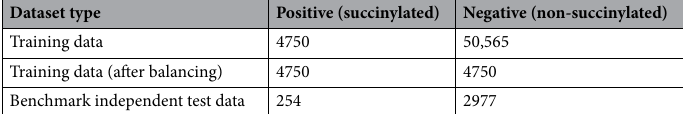
Table 1. Dataset description of the training and independent test